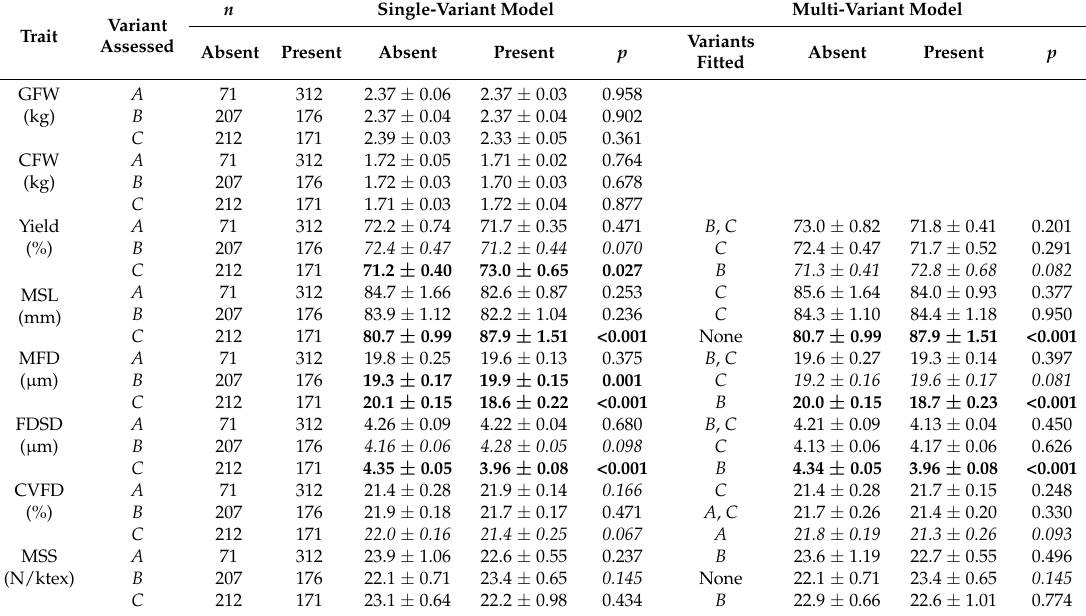
Table 3. Association between the KRTAP26-1 variants and various wool traits (predicted mean ± predicted SE) 1 . n Single-Variant Model Multi-Variant Model Variant Trait Assessed Absent Present Absent Present